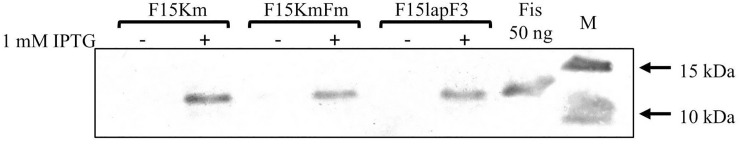
Overexpression of fis in P. putida cells determined by immunoblotting using polyclonal anti-Fis antibodies.Immunoblot analysis was performed with crude cell lysates prepared from P. putida strain F15 grown in LB medium for 18 h. The supplementation of 1 mM IPTG is shown by “+” above the lane. Thirty micrograms of crude cell lysate were analysed. Fifty nanograms of purified Fis (6His) was used as a positive control. Arrows show the location of marker proteins 15 and 10 kDa in size in the marker (M) lane.